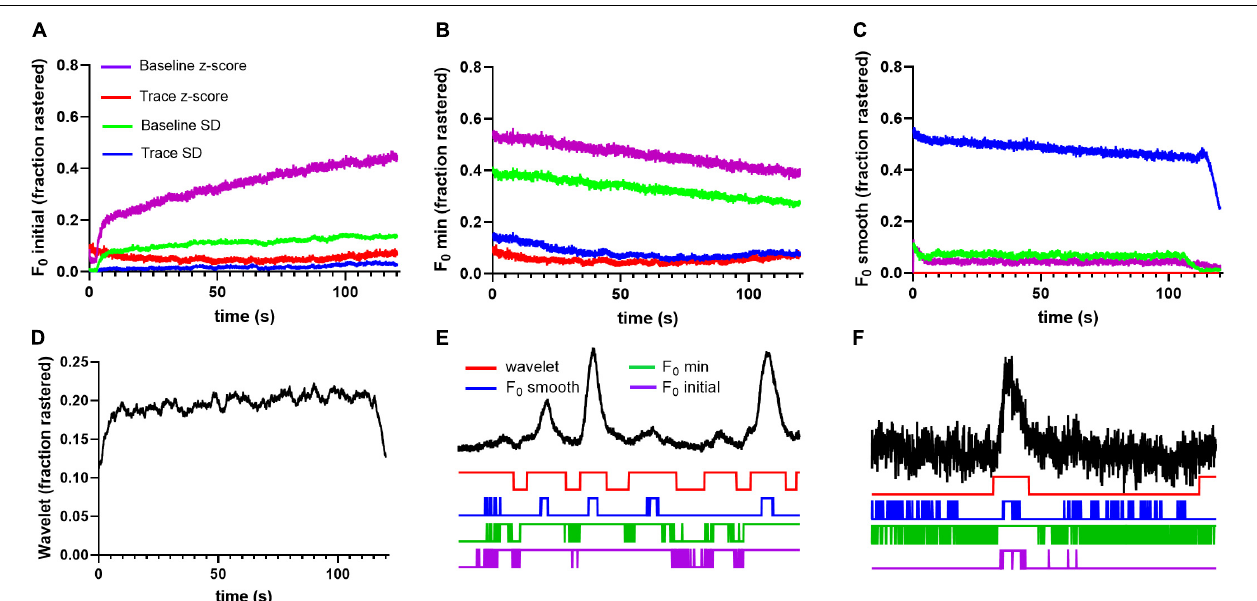
FIGURE 8 | Event detection methods find highly variable raster probabilities for astrocytic recordings. (A) F 0 initial thresholding methods produce largely unstable results with varying raster probabilities, as do F 0 minimal thresholding methods in (B) . (C) F 0 smooth produces stable probabilities, but those probabilities vary between thresholds. (D) Wavelet ridgewalking identifies stable raster probability that is slightly higher than found for neurons. Long duration of astrocytic events makes them more likely to be cut off at the beginning and end of time series leading to a drop in probability of detection by wavelet ridgewalking. (E) A 1-min trace of high SNR astrocyte fluorescence trace with example rasters beneath. Even in these high SNR conditions, the F 0 thresholding methods introduce fragments. The F 0 smooth method, which performed well identifying calcium transients in high SNR neuronal traces, does worse with astrocytic traces as seen in this example, probably due to their relatively slower kinetics. (F) A 1-min segment of a low SNR astrocytic trace taken from above the calculated rasters. Once again, in low SNR conditions, the F 0 thresholding methods introduce multiple